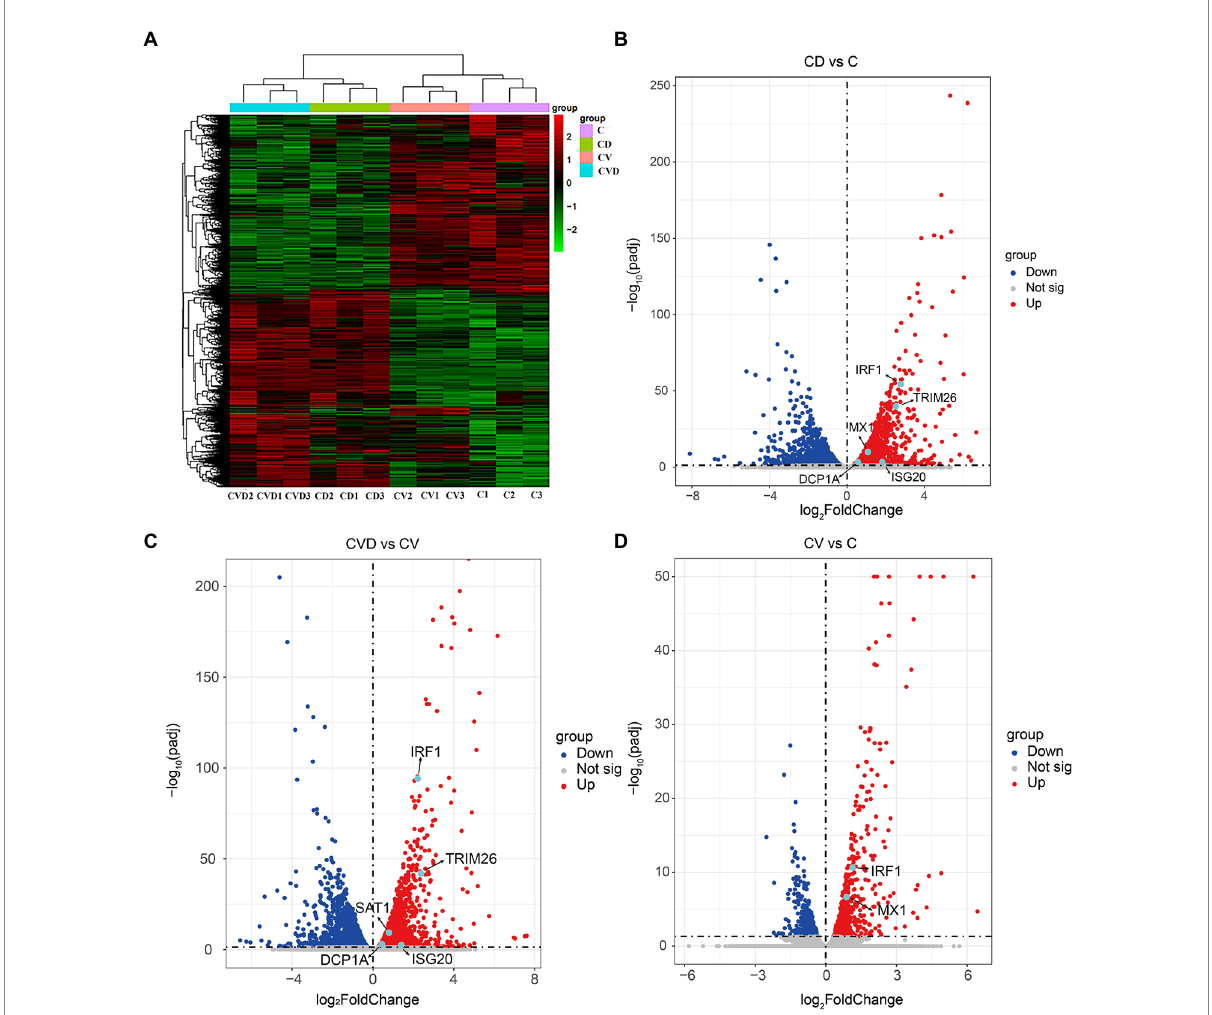
FIGURE 8 Heat map and volcano map of differentially expressed genes obtained by high-throughput sequencing of samples from different treatment groups. (A) Heap map of differentially expressed genes in different treatment groups. (B) Volcano map of differentially expressed genes in the CD group (PAMs incubated with TSN) compared with the C group (mock). (C) Volcano map of differentially expressed genes in the CVD group (ASFV- infected PAMs incubated with TSN) compared with the CV group (ASFV-infected PAMs). (D) Volcano map of differentially expressed genes in the CV group compared with the C